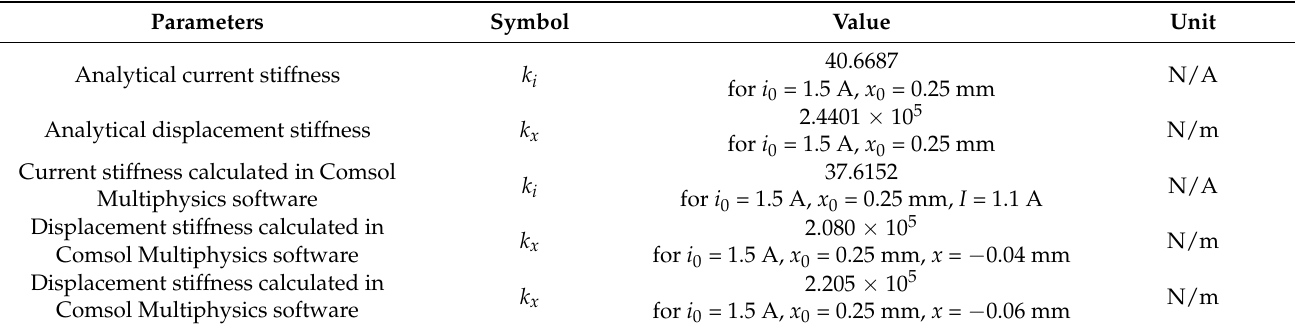
Table 3. Current and displacement stiffness coefficient calculated analytically and using Comsol Multiphysics software.